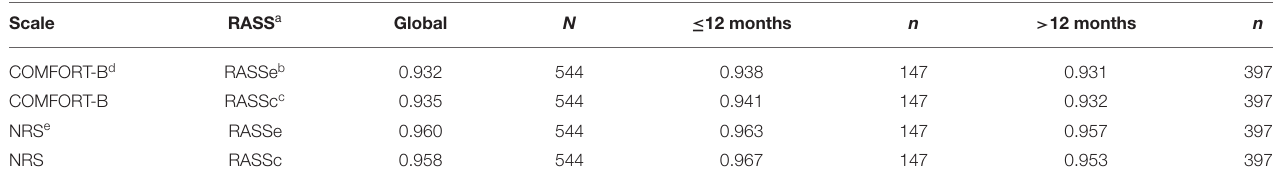
TABLE 3 | Spearman rho correlation between RASS and COMFORT-B and between RASS and NRS, in the global population and in children < or > 12 months ( p < 0.001 in all cases). Scale RASS a Global COMFORT-B d COMFORT-B